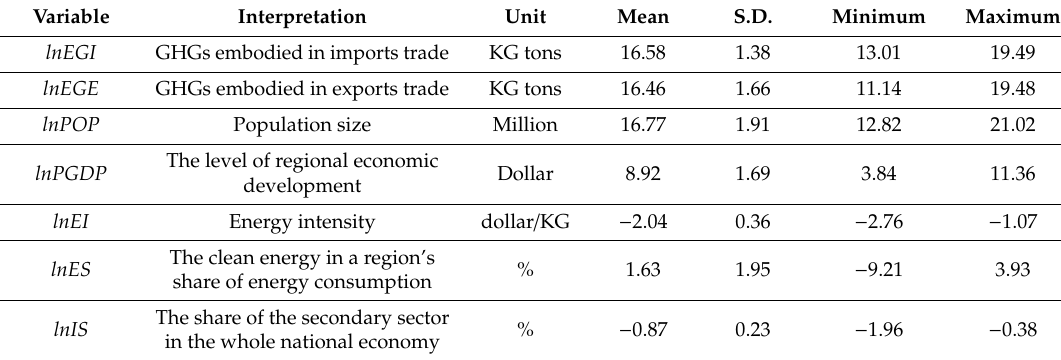
Table 1. Descriptive statistics of the data set involved in this paper.